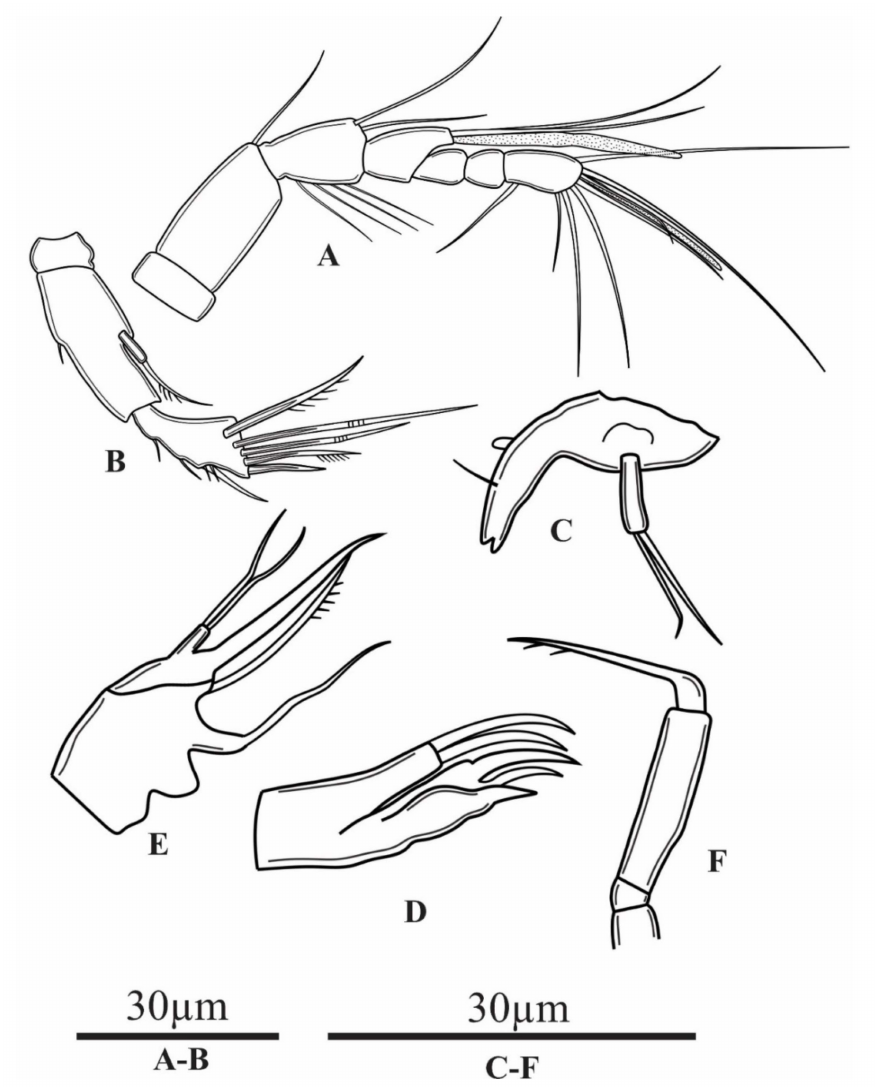
Figure 11. Parastenocaris vugiaensis sp. nov. female. ( A ), antennule; ( B ), antenna; ( C ), mandible; ( D ), maxillule; ( E ), maxilla; ( F ),